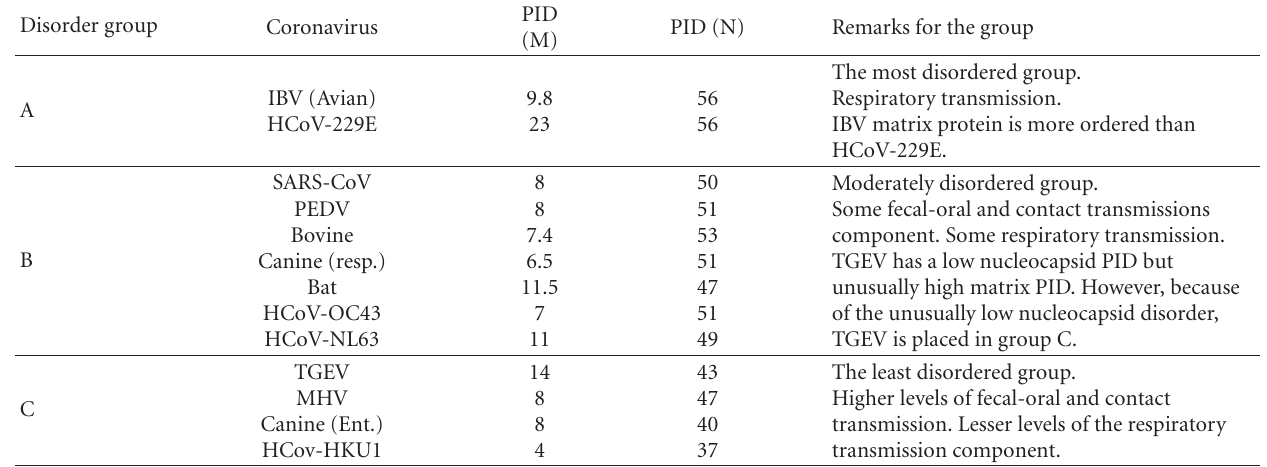
Figure 6: 3D representation with predicted disorder annotation of the parts of the nucleocapsid proteins of IBV and SARS-CoV [7, 8]. (a) SARS-CoV (PDB ID: 2gib); (b) IBV (PDB ID: 2c86) Avian infectious bronchitis virus (IBV). The red color denotes residues predicted to be disordered by PONDR VLXT, while cyan and green represent regions that are predicted to be ordered with the two colors used to distinguish between separate subunits. The mean PID of the IBV N-protein is 56%, whereas the corresponding PID of SARS-CoV N-protein is only 50% (see Table 3). The N-protein of HCoV-299E is more similar to the IBV N-protein in this respect. Table 3: A new categorization of coronaviruses by predicted